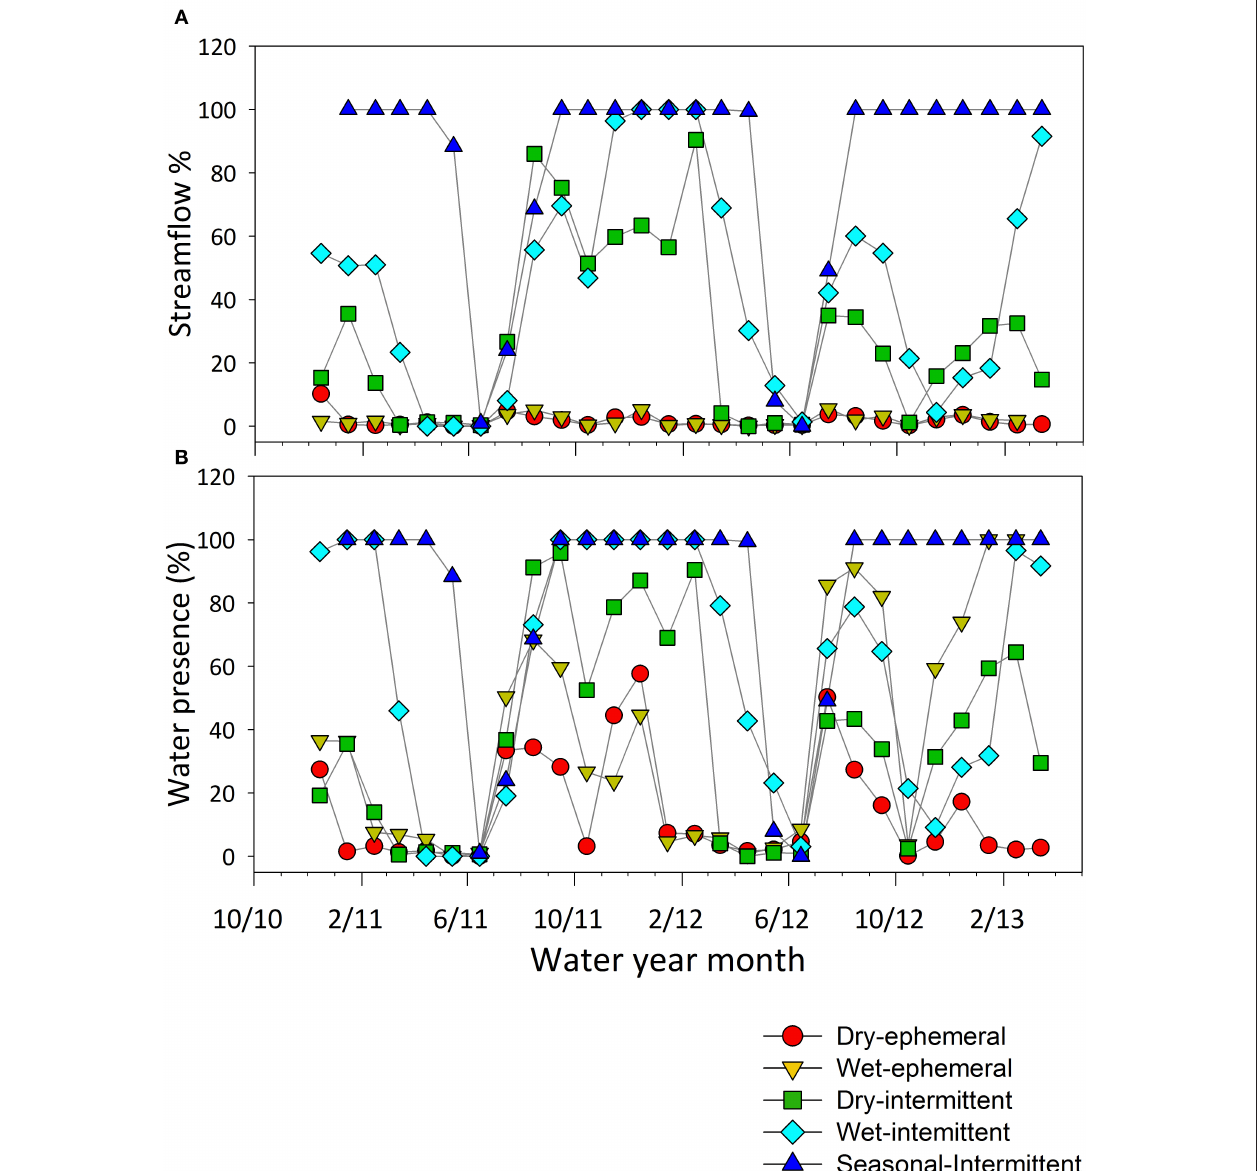
( Figure 8B ). The potential annual infiltration to annual PPT ratio (I:PPT), assuming that only 50% of the stream substrate contributes to infiltration, ranged from 0.1 to 8.7; whereas the ratio varied from 0.2 to 14.8 assuming that the